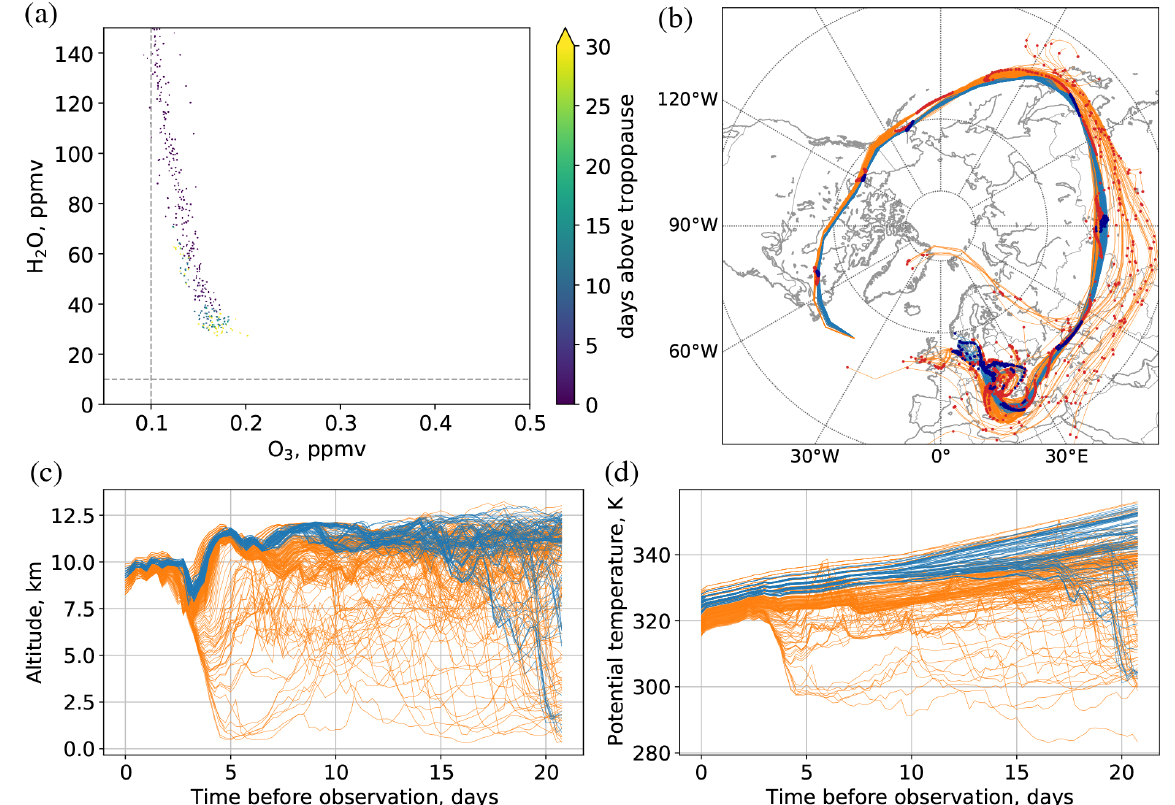
Figure 5. Panel (a) shows ozone–water vapour tracer–tracer correlation for 7 October flight below 330K potential temperature. Colour scale shows stratosphere residence time; tropospheric air parcels are included with zero residence time. The remaining panels show backward trajectories for air parcels from (a) air with less than 40ppmv H 2 O and residence time above 10d (blue), and air with 40 to 100ppmv H 2 O (orange). Trajectories in panel (b) have markers every 24h (red for orange trajectories; dark blue for blue) and are plotted for 10d in